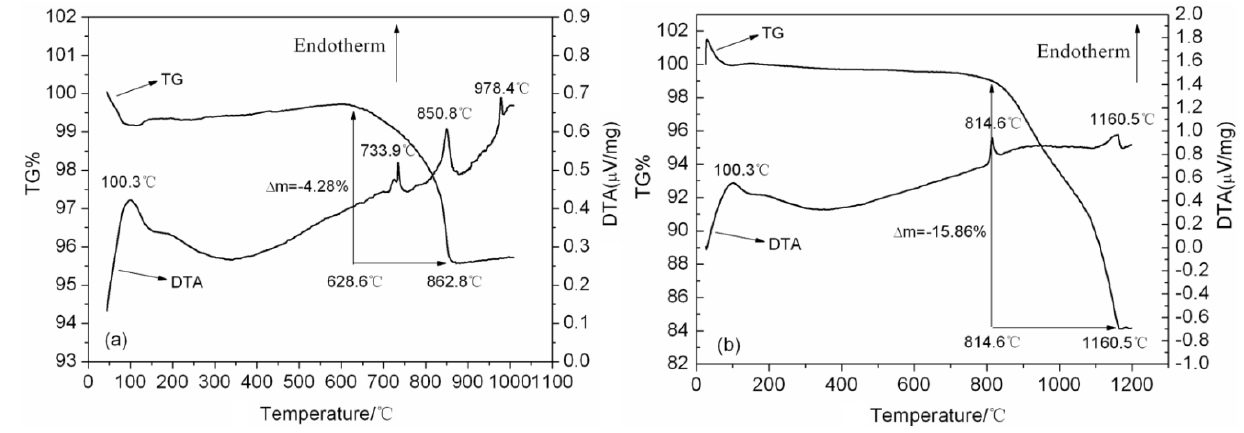
Figure 1. TG-DTA curves of ( a ) Na 2 CO 3 + Bi 2 O 3 + 4TiO 2 ; and ( b ) BaCO 3 + TiO 2